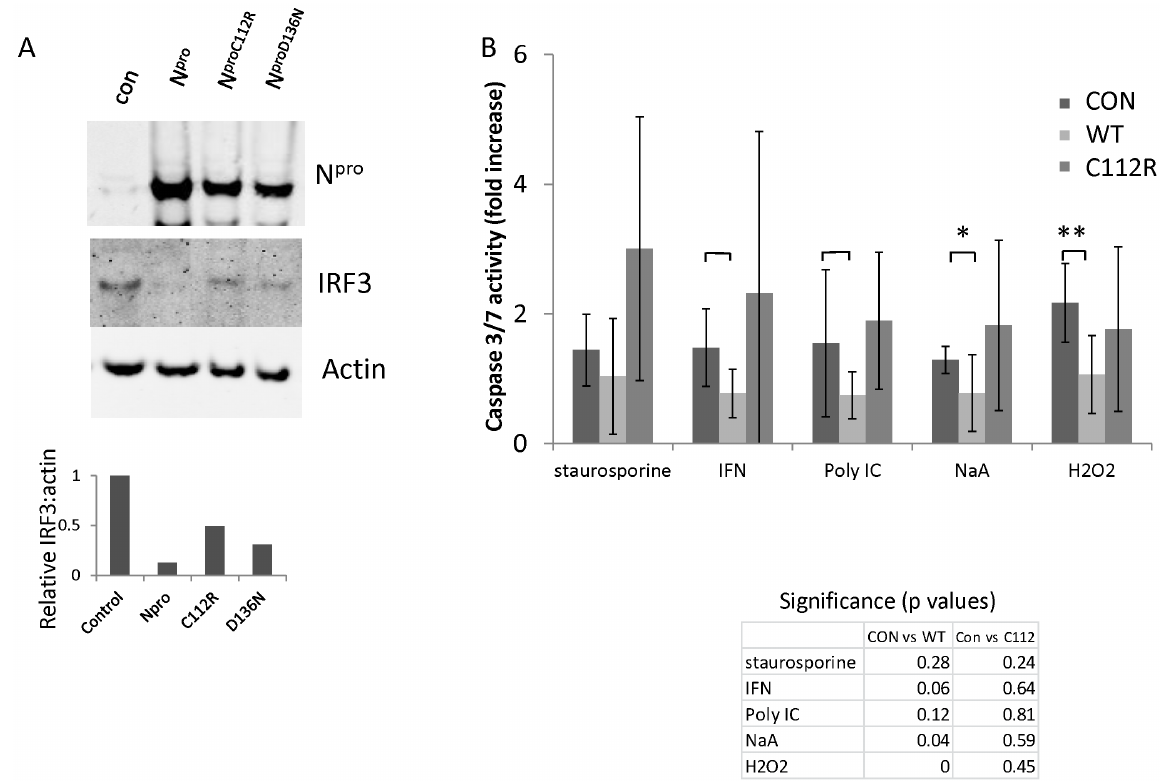
Figure 1. Inhibition of apoptosis by N pro correlates with degradation of IRF3. (A). Western blotting of lysates from MEF cell expressing N pro cherry with antibodies against N pro , IRF3 and actin shows loss of IRF3 from cells expressing N pro . Lane 1: Control MEF cells not expressing plasmid. Lane 2: MEF cells stably expressing N pro mcherry. Lane 3 : MEF cells expressing N pro C112R mcherry mutant. Lane 4: MEF cells expressing N pro D136N cherry mutant. Graph shows relative intensities of IRF3 compared to actin for the image scanned with Scion image software http://scion-image. software.informer.com (representative of Western blot repeated three times for each lane). (B). N pro but not N pro C112R inhibits caspase 3/7 activity. MEF cells stably expressing wild type N pro or mutant N pro C112R mcherry were treated with staurosporine, interferon, dsRNA (poly I:C), sodium arsenate (NaA) or hydrogen peroxide (H 2 O 2 ) for 4 hrs. Fold increase in caspase activity was normalized to negative (untreated cells) for each cell line and analyzed with a two-sided t-test with unequal variance relative to the untransfected cells for each cell line, and significance values are: bars marginally significant (0.05–0.1), * significant (0.01–0.05), ** highly significant (0–0.01) (n=5 to 8). The table shows significance of drug treatment relative to control treated cells for cells expressing N pro WT or N pro C112R and analysis was conducted using similar tests as described